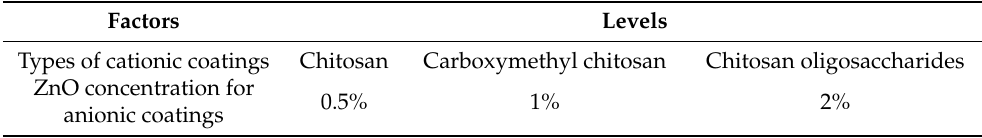
Table 4. Factors and levels of the assay design.